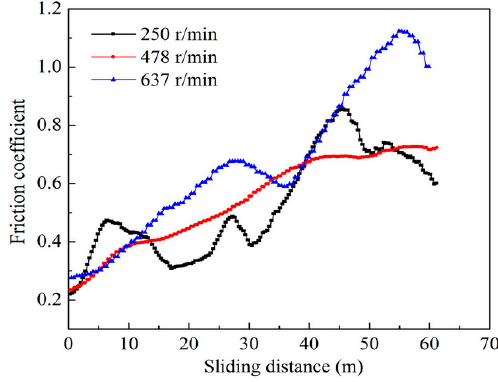
Figure 4. Friction coefficients of UIRP samples under different sliding speeds.